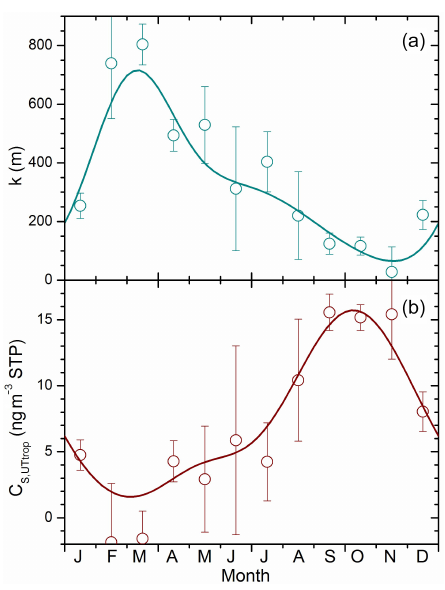
Figure 5. Seasonal variation of (a) the sensitivity of the UT par- ticulate sulfur concentration to the concentration slope in the LMS ( k ) and (b) the UT particulate sulfur concentration of tropospheric origin ( C S , UTtrop )